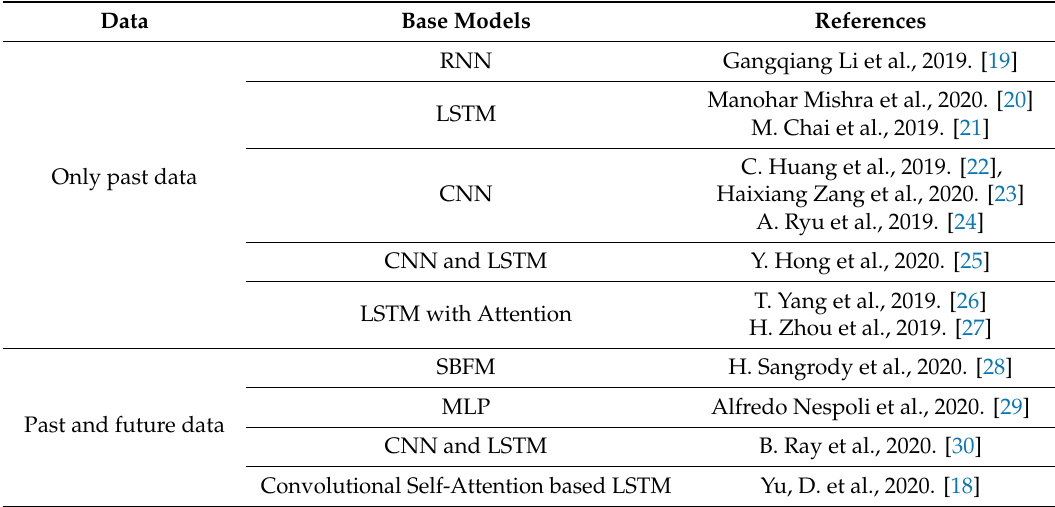
Table 1. Overview of related work on PV power generation forecast.